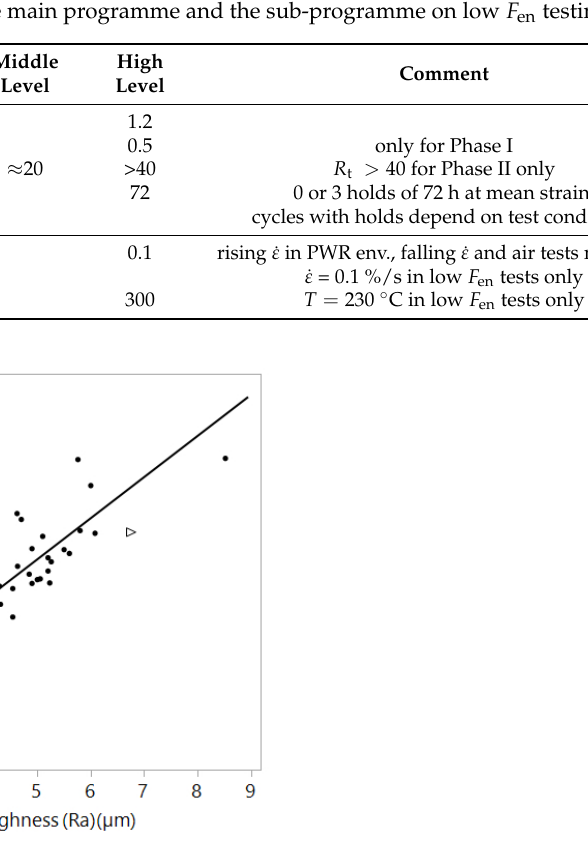
Figure 1. Correlation between R t and R a for the specimens in the database (throughout this work, the symbol (cid:46) indicates runout specimens). The ratio between R t and R a is 8.7.